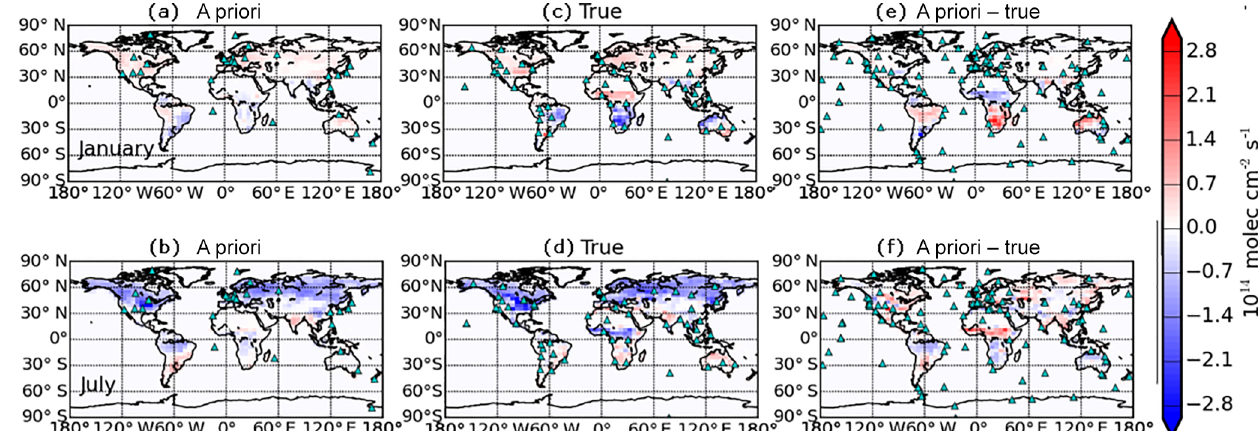
Figure 4. Distribution of land biosphere CO 2 fluxes (10 14 moleccm − 2 s − 1 ) for January (a, c, e) and July (b, d, f) in our study year, described on the 4 ◦ latitude × 5 ◦ longitude GEOS-Chem model grid. (a, b) show the CASA model that we used as our a priori, (c, d) show output from the ORCHIDEE land surface model that we use to define the true state, and (e, f) show the difference between ORCHIDEE and the CASA model. The cyan triangles represent observation sites from (1) current and future TCCON networks (a, b) , (2) the enhanced mini-LHR network (c, d) , and (3) the subset of the NOAA ground-based network (e, f) .